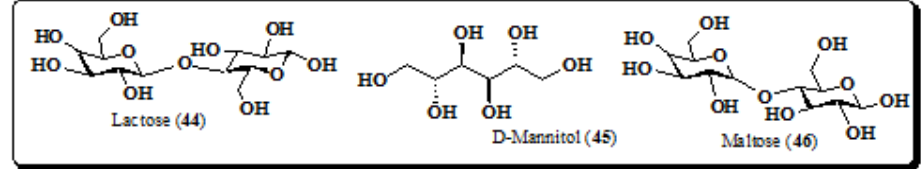
Figure 6. Structures of carbohydrates from E. laevis ( 44 – 46 ).